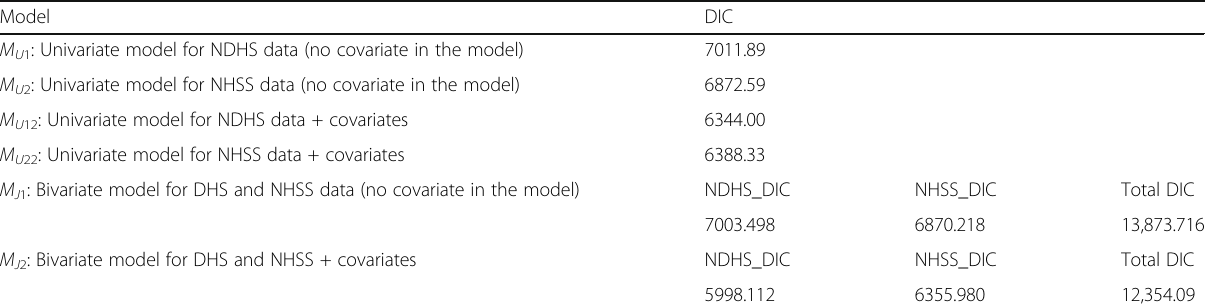
Table 3 DIC values for fitted models